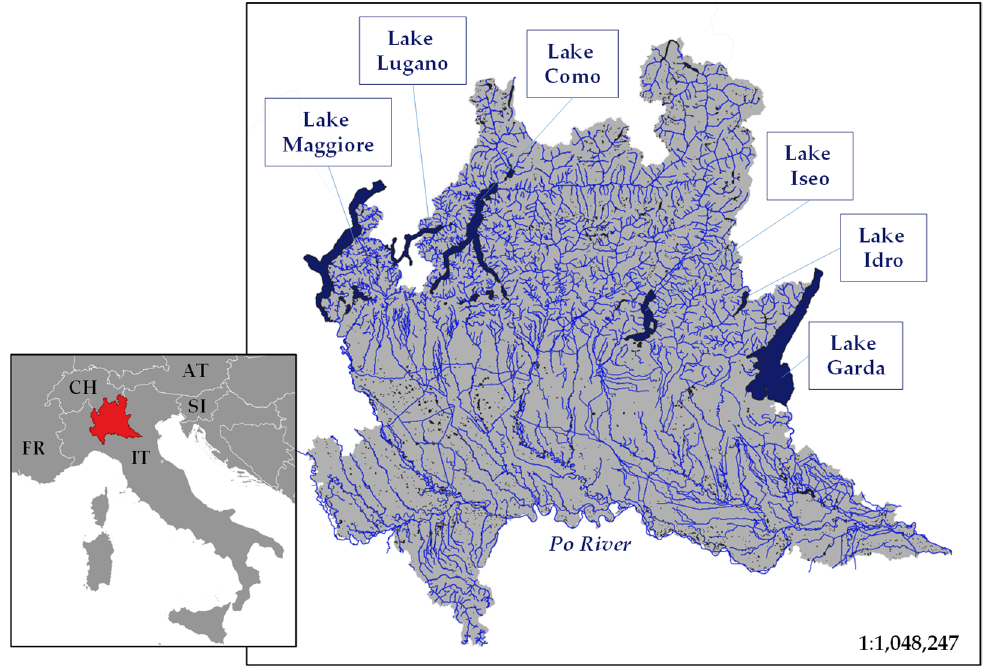
Figure 1. Surface waters of the Lombardy Region (Northern Italy). The main six lakes along with the Po River are indicated in the